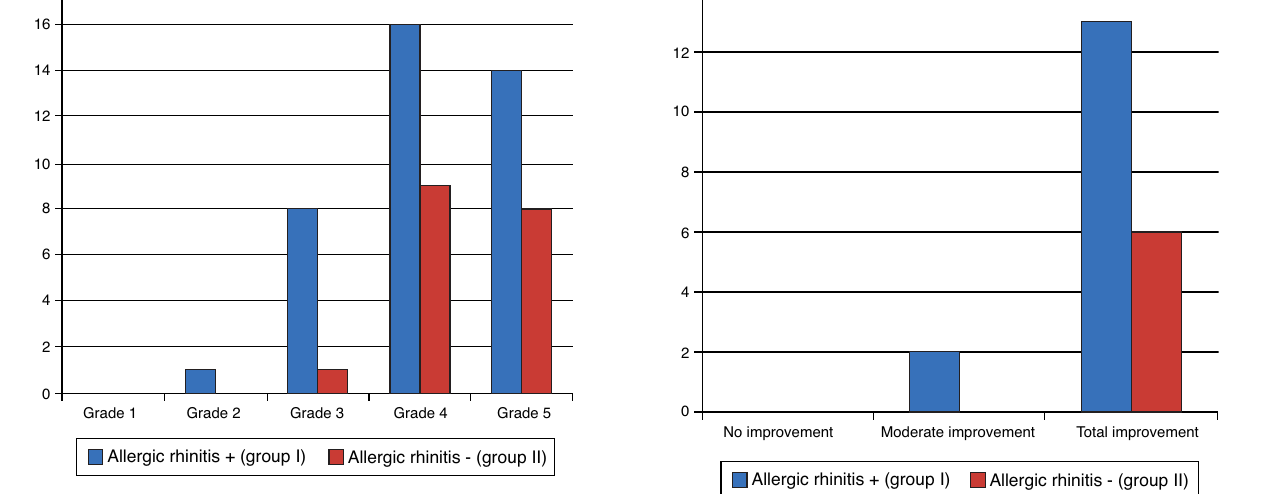
Figure 8 Degree of breathing improvement --- 30th day post- operatively.